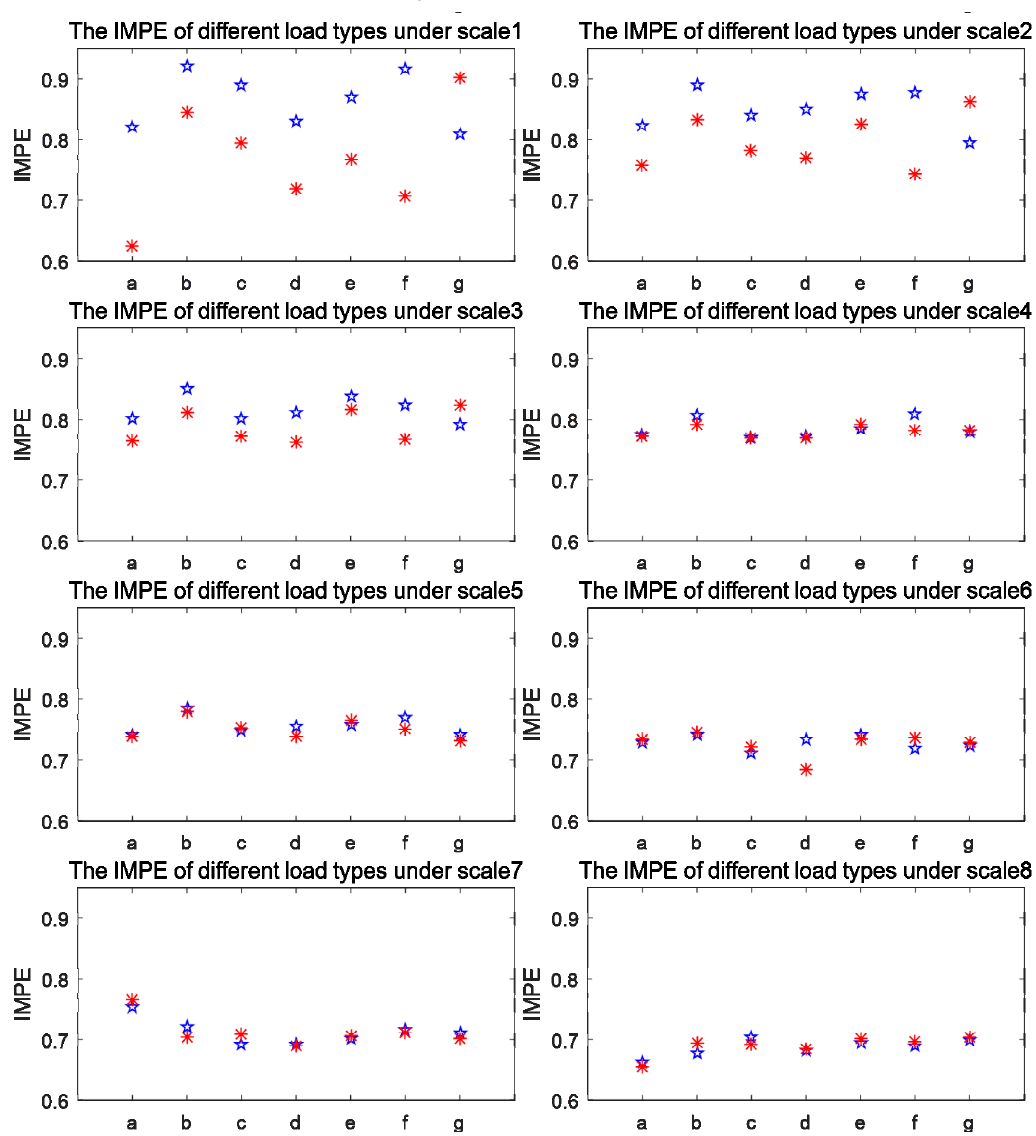
Figure 9. The improved multi-scale permutation entropy (IMPE) of different load types during normal operations and serial arc fault conditions after filtering. (a) Induction cooker. (b) Incandescent lamp. (c) Hairdryer. (d) Notebook computer. (e) Electric drill. (f) Electric oven. (g) Vacuum cleaner.